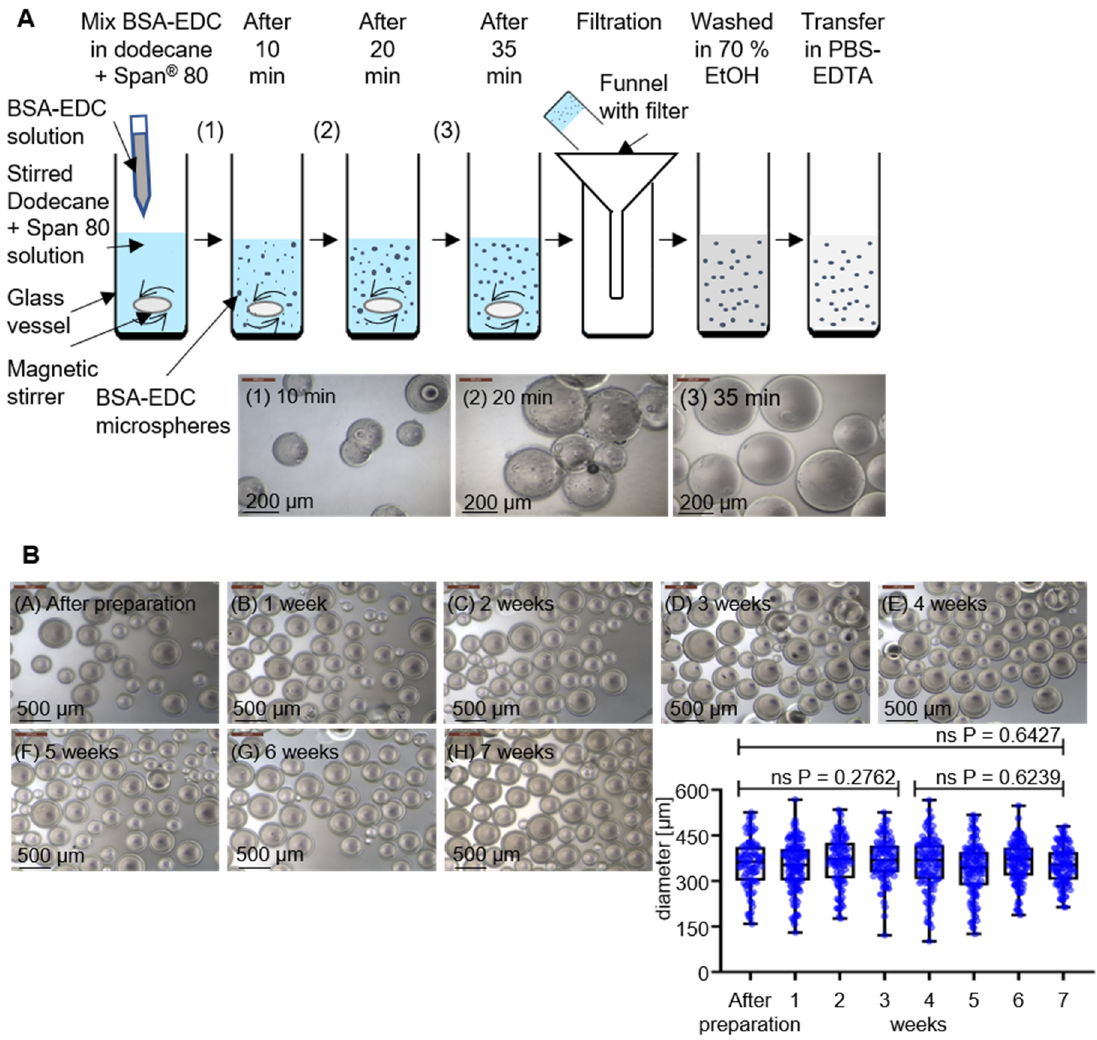
Figure 1. Preparation and stability analysis of BSA-EDC hydrogel beads. ( A ) Preparation of BSA-EDC beads through carboxy- and amino group crosslinking in dodecane and Span ® 80 with crosslinking stages of 10, 20, and 35 min and phase-contrast microscopy observation at 100 × magnification. ( B ) Dimensional stability from BSA-based hydrogel beads over 7 weeks in PBS-EDTA buffer and phase-contrast microscopy visualization at 50× magnification for determination of the diameter stability. The determined p -values of unpaired t-tests with Welch’s correction show no significant (ns) changes in the diameter over the time.